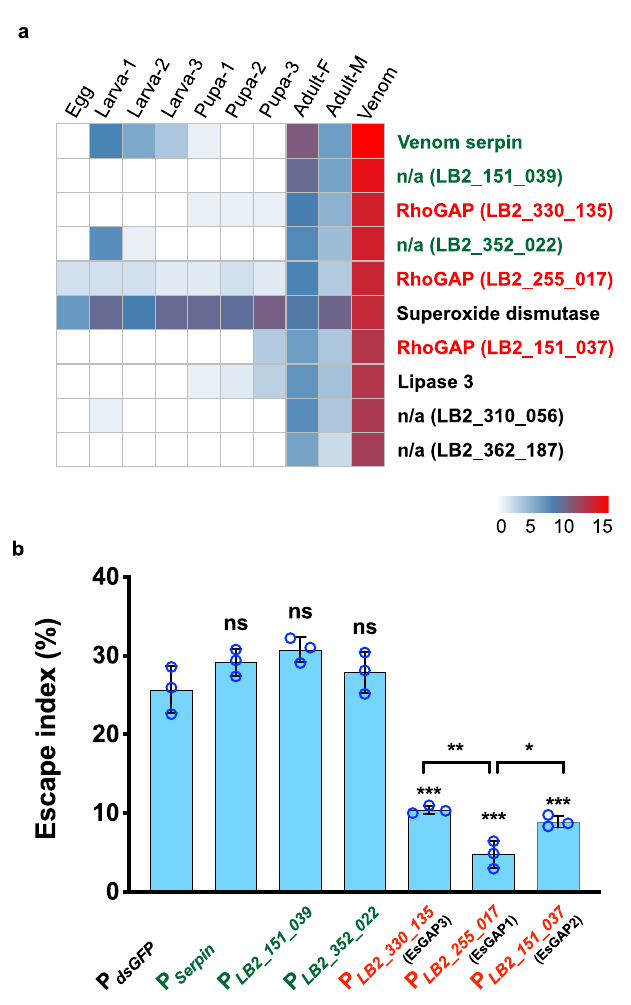
Fig. 2 A family of EsGAP venom proteins contributes to escape behaviour. a Transcription heatmap of all venom-protein genes that were signi fi cantly highly expressed in venom. Genes are displayed in order of expression levels in the venom. The three genes in red were predicted to have RhoGAP domains and were subjected to functional testing together with another three highly expressed genes (in green). b Escape indices of host larvae that were parasitized by Lb with knockdown of the indicated proteins using an RNAi strategy. dsGFP -treated Lb (P dsGFP ) was used as a control. Drosophila larvae infected by parasitoids with knockdown of EsGAP had the lowest escape index. The number of larvae exhibiting escape behaviour was recorded from 30 min to 75 min after exposure to Lb. Left to right: n = 360, 278, 323, 424, 317, 391 and 316 biologically independent host larvae. Three biological replicates were performed. Data are presented as mean values± SD. Signi fi cance was determined by two-sided unpaired Student ’ s t test (P Serpin : P = 0.1564; P LB2_151_039 : P = 0.0609; P LB2_352_022